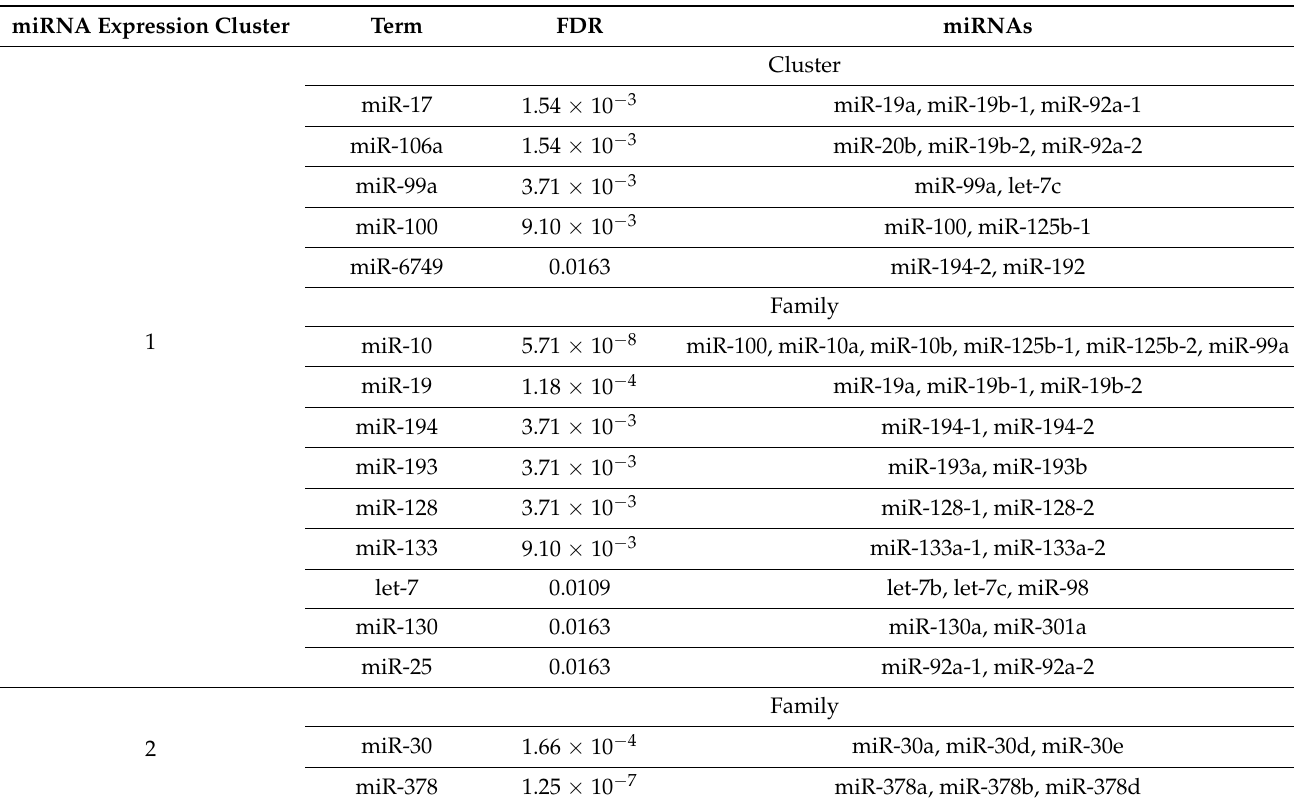
Table 3. MiRNA enrichment analysis. MiRNA expression cluster indicates the correspondence of the cluster indicated in Figure 3; FDR is for false discovery rate. The column “miRNAs” shows a list of miRNAs that fall within the term and whose expression is recovered with pargyline treatment. miRNA Expression Cluster Term FDR